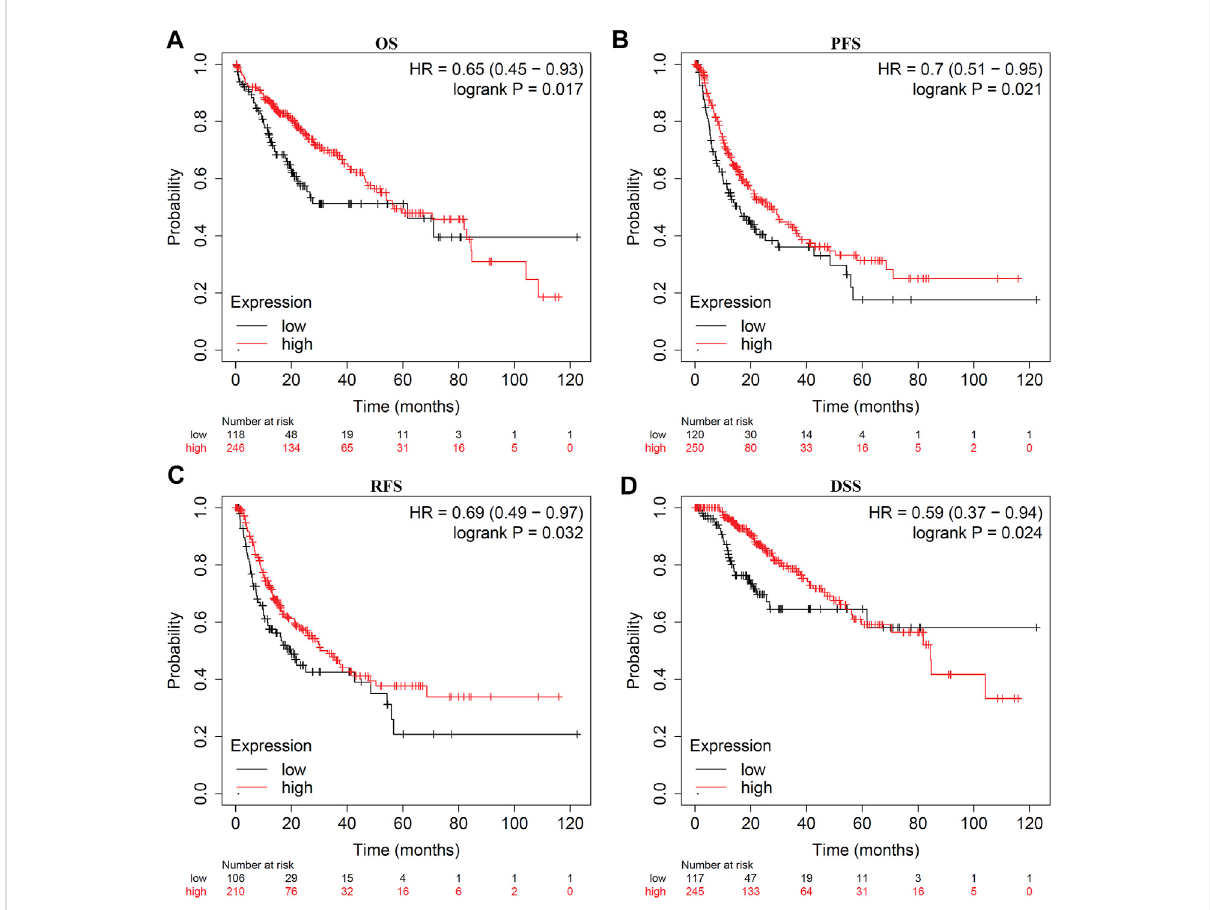
FIGURE 3 Kaplan-Meier plots for LDOC1 and overall survival (OS), progression-free survival (PFS), recurrence-free survival (RFS), and disease-speci fi c survival (DSS). (A) Kaplan-Meier plot of LDOC1 and overall survival. (B) Kaplan-Meier plot of LDOC1 and progression-free survival. (C) Kaplan-Meier plot of LDOC1 and recurrence-free survival. (D) Kaplan-Meier plot of LDOC1 and disease-speci fi c